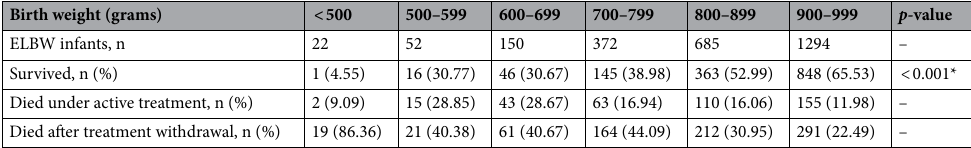
Table 3. The survival rate of extremely low birth weight (ELBW) infants in relation to birth weight. ELBW, extremely low birth weight. *Chi-square test linear-by-linear association.